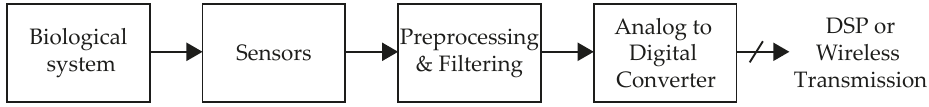
Figure 1. Block diagram of a typical biomedical signal processing